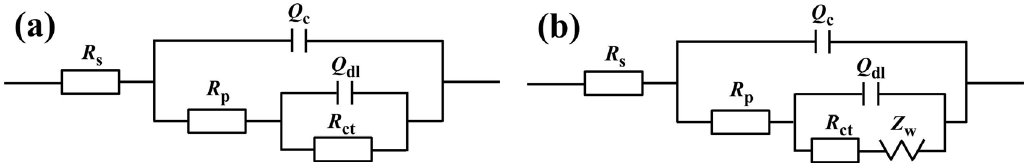
Figure 6. Equivalent circuits used to fit EIS data of unsealed and sealed nanostructured WC-CoCr coatings in ( a ) 3.5 wt % NaCl and ( a , b ) 1 mol ∙ L − 1 HCl. Table 3. Electrochemical impedance spectroscopy (EIS) fitted parameters of unsealed and